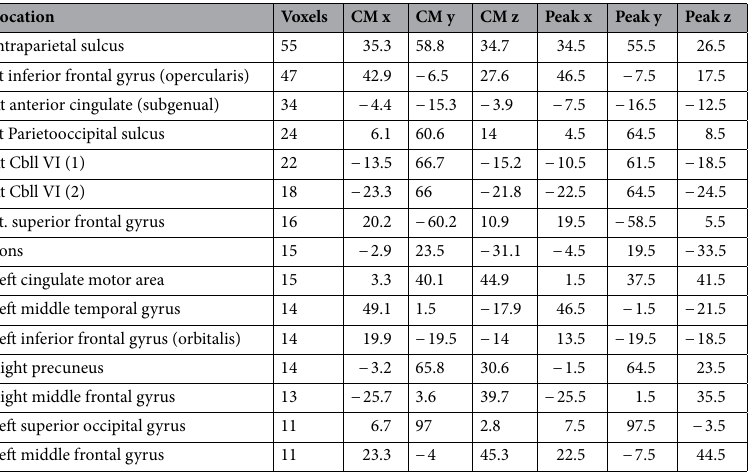
Table 2. Locations of 15 clusters from Fig. 2 in Talairach coordinates in N27 Colin template. CM, center of mass; Voxels, number of voxels in each